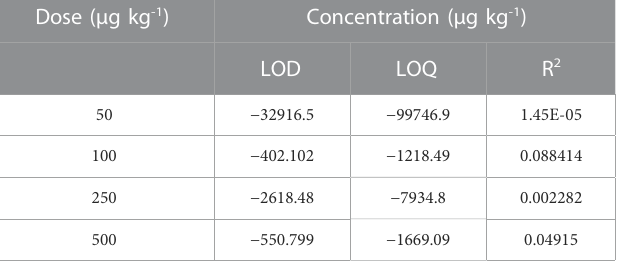
TABLE 6 Validation parameters of EB metabolite Emamectin B 1a . Dose (µg kg -1 )